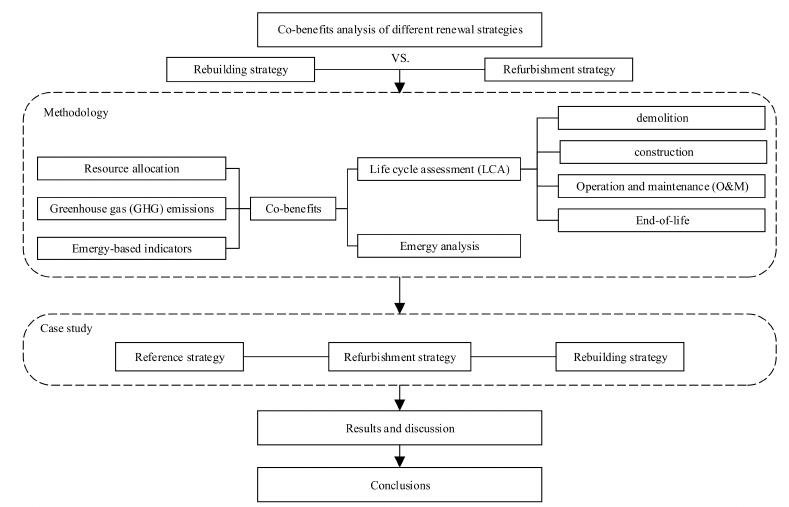
Figure 1. Research